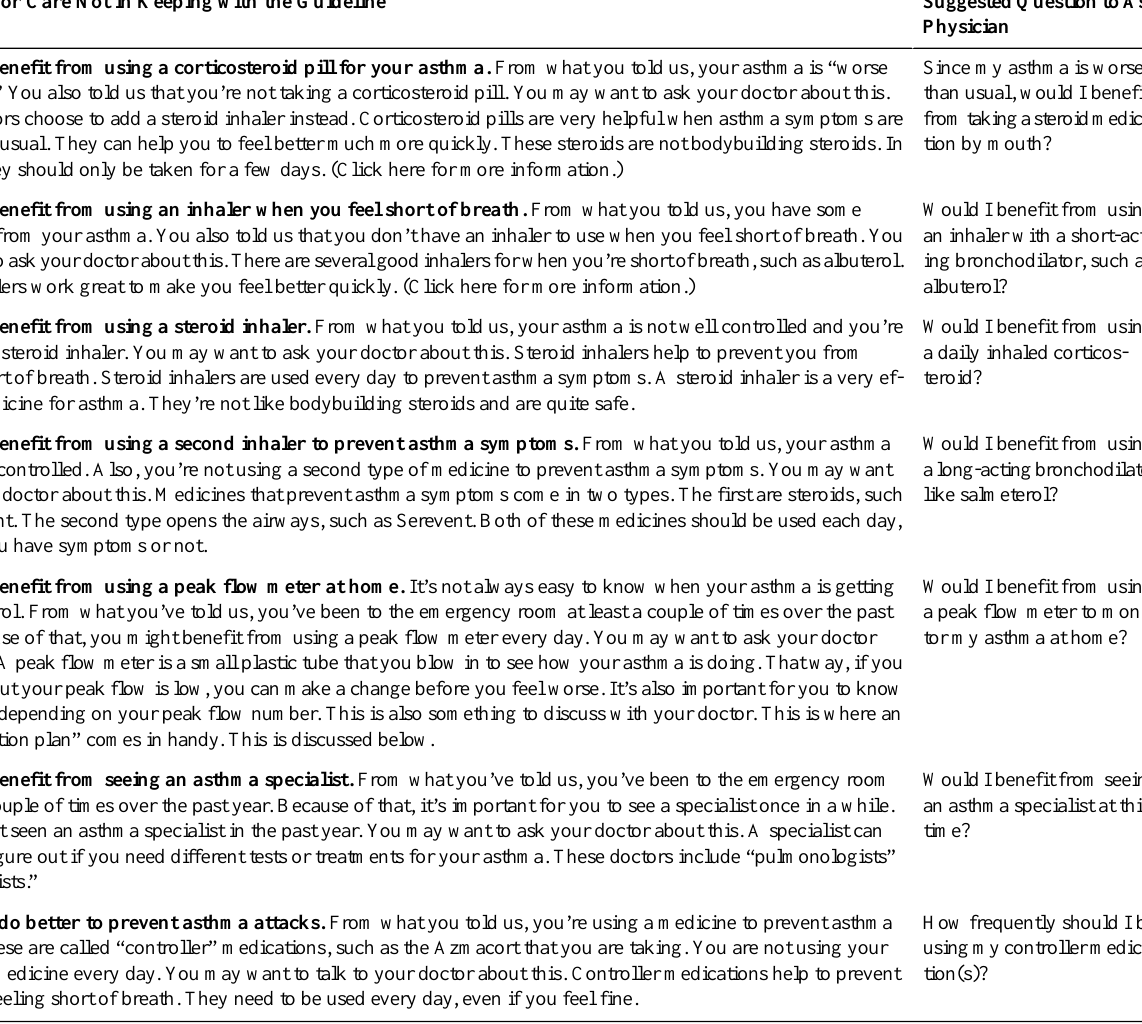
Table 1. Website feedback and suggested question